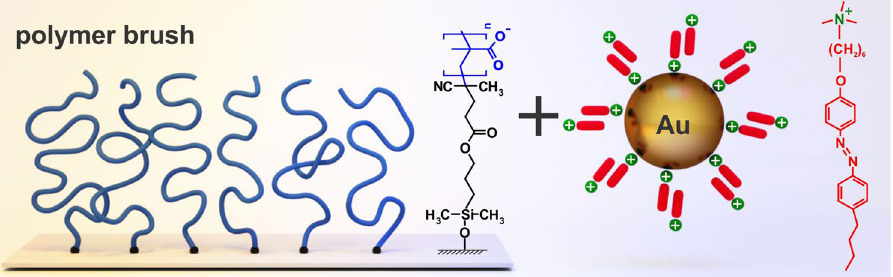
Figure 1. Scheme and chemical structure of the PMAA polyelectrolyte brush (blue) and cationic azobenzene containing surfactant (red). Negatively charged gold nano-particles are mixed first with cationic surfactant followed by adsorption within the